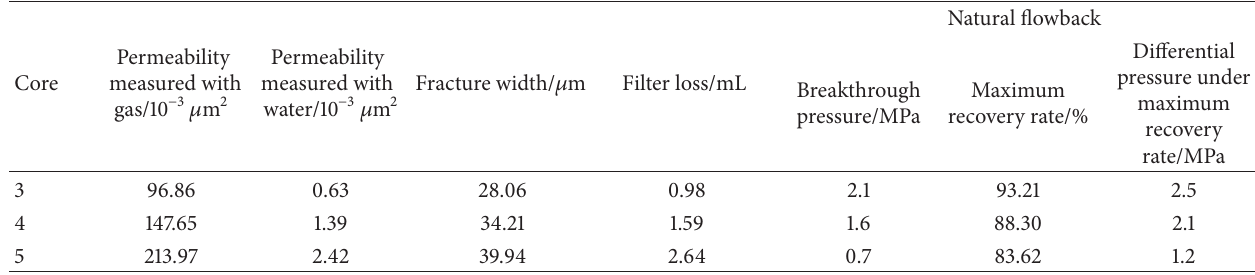
Table 6: Results of dynamic damage